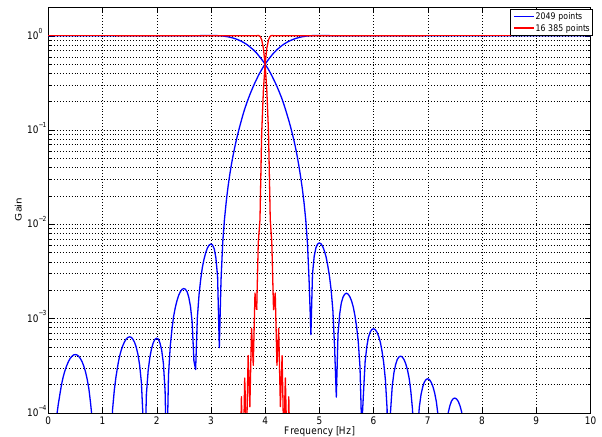
Figure 9. Frequency response of two merging filters with different filter